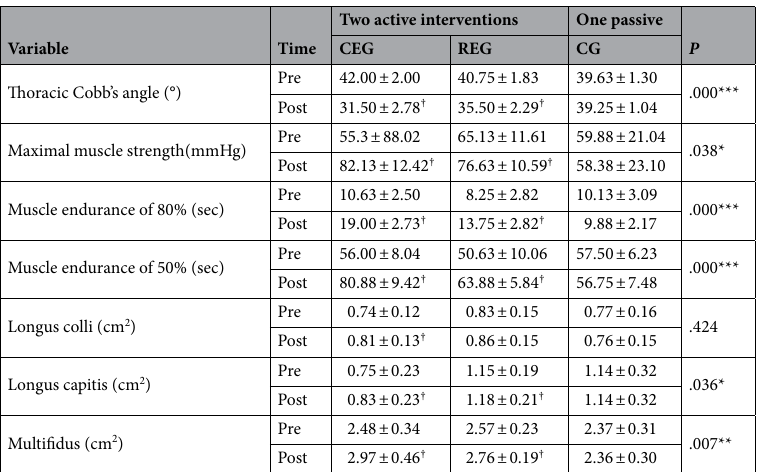
Figure 2. The difference of cross-sectional area in cervical deep muscles after intervention. ( a ) Longus colli muscle; ( b ) Longus capitis muscle; ( c ) Multifidus muscle. CEG, corrective exercise group; REG, resistance exercise group; CG, control group; CSA, cross-sectional area; DNF, deep neck flexor. P < 0.0167*, P < 0.00167**: the results from Bonferroni correction.